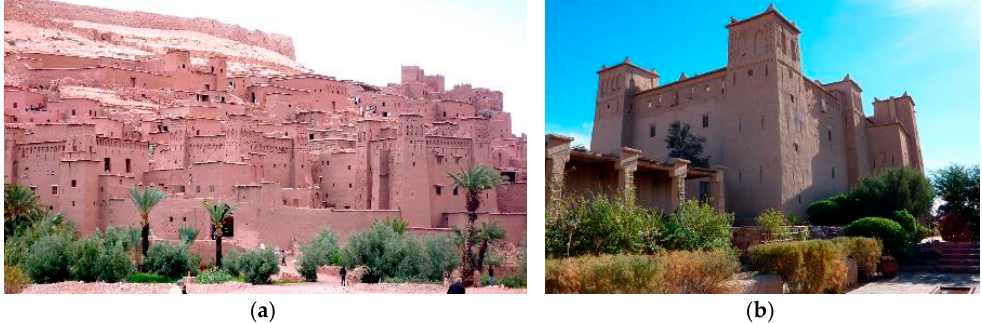
Figure 4. Two examples of kasbah restorations. ( a ) Ait Ben Haddou. UNESCO Word Heritage Site; ( b ) Kasbah of Ait Ben Moro. Skuora.